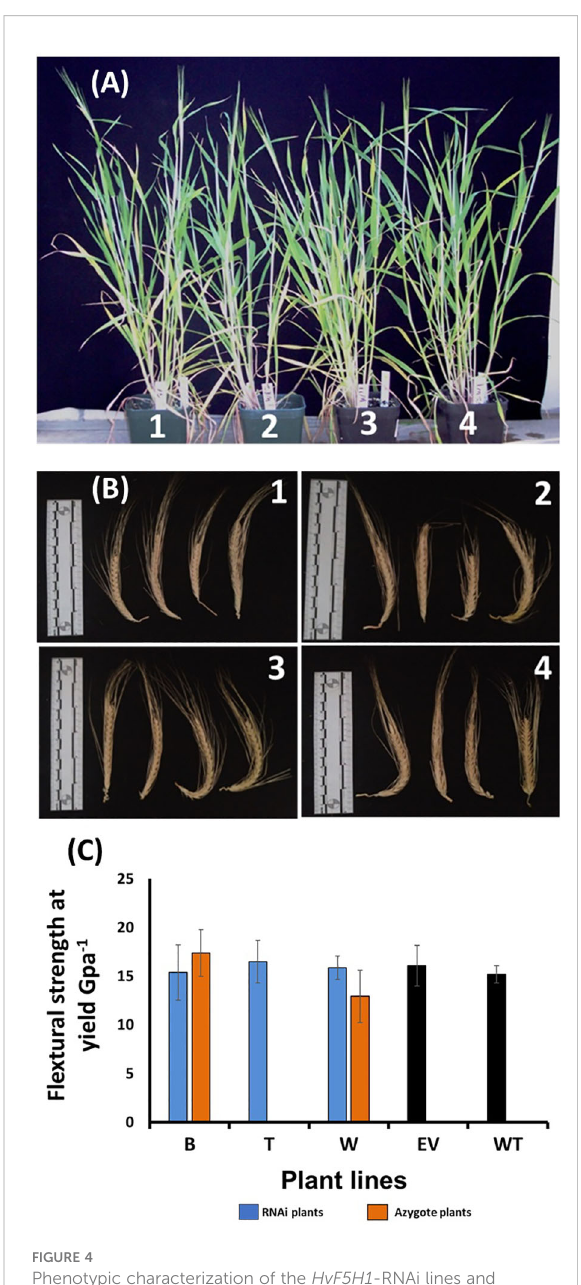
FIGURE 4 Phenotypic characterization of the HvF5H1 -RNAi lines and controls from the T2 generation; (A) plant stature and (B) spikes at harvest time, where 1,2,3,4 are wild type, empty vector, azygote and HvF5H1 RNAi plants respectively; (C) mechanical strength of the second and fourth internodes sampled from main tillers of the ripe senesced straw; No signi fi cant differences were identi fi ed (P < 0.05) following Student ’ s t ‐ test. B, T, W are RNAi lines and B and W have corresponding azygote lines. For line T where no azygotes were available, empty vector and wild type plants were used as controls. The error bars represent standard errors between biological triplicates (i.e. independent